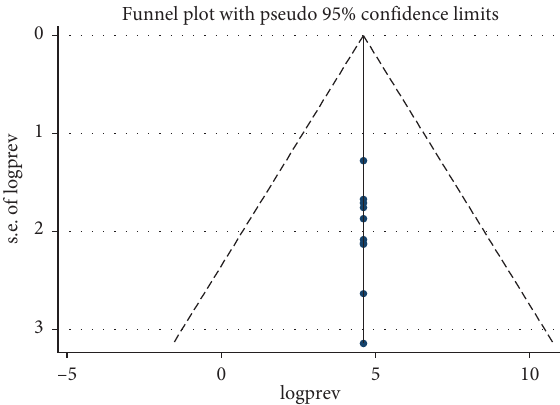
Figure 4: Funnel plot to test publication bias of the 10 studies.